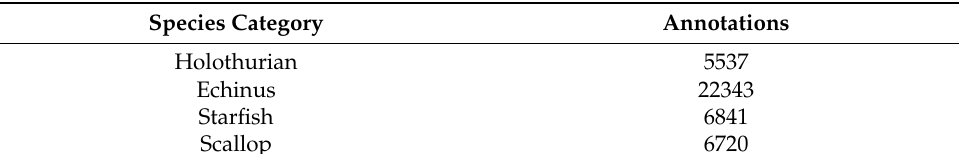
Figure 8. The visual annotations of the brackish dataset.